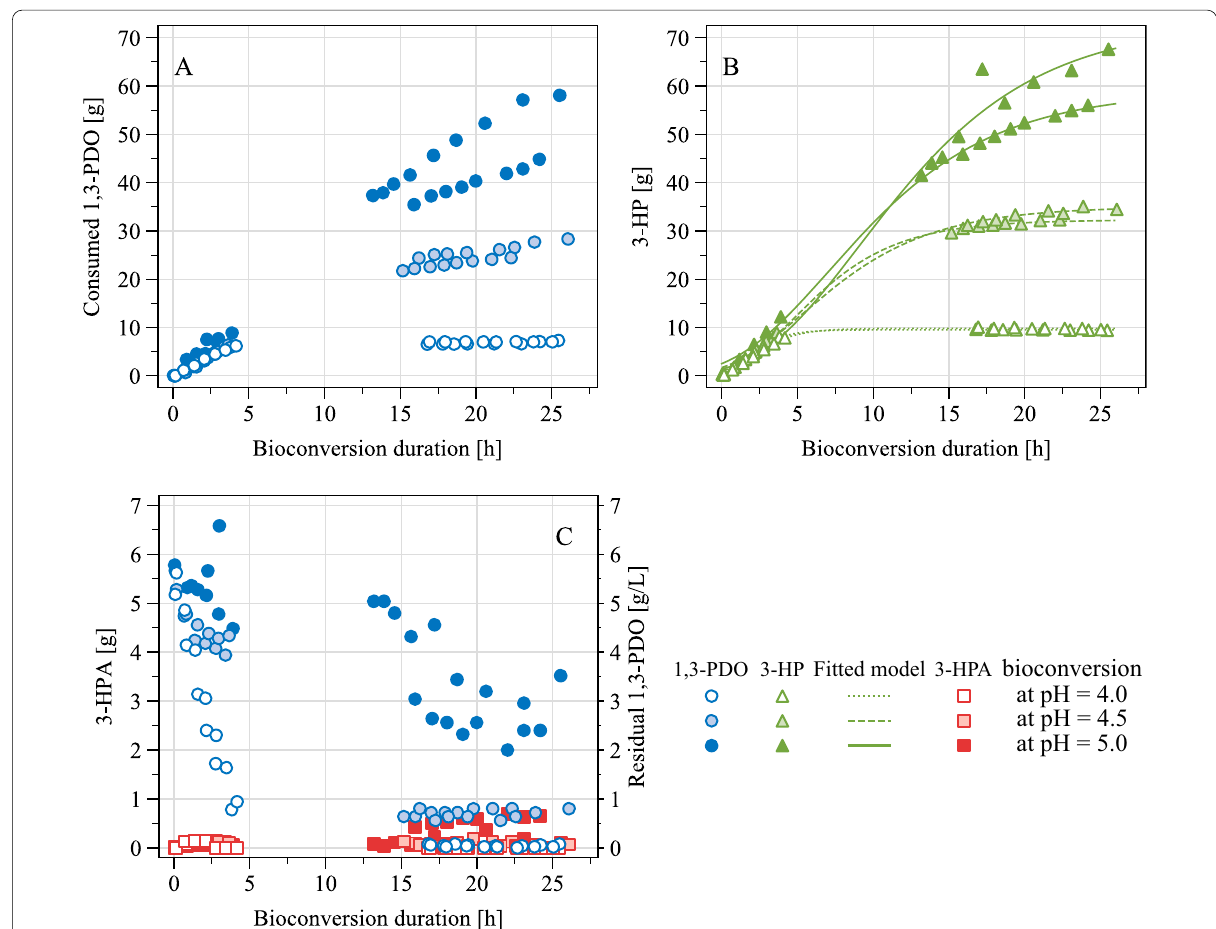
Fig. 4 Bioconversion of 1,3‑PDO into 3‑HP by growing cells of Acetobacter sp. CIP 58.66 in a pH‑based fed‑batch, preceded by a first growth step on glycerol in batch mode. A Overall 1,3‑PDO consumption. B Overall 3‑HP production. C 3‑HPA production and residual 1,3‑PDO in the bioconversion broth. These bioconversions were launched after a 32 h‑long growth on glycerol. Therefore t For each pH condition, n 2. Depending on replicates, initial working volumes were estimated to be between 0.91 and 0.96 L, and final volumes = between 0.83 and 0.91